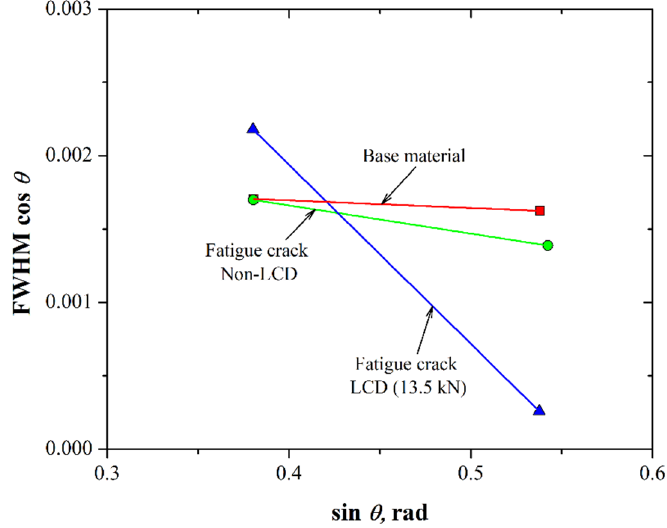
Figure 10. Residual strain approximation obtained from the fitting to the Williamson–Hall equation (Equation (3)) for the 7075-T651 aluminum alloy. (Equation (3)) for the 7075-T651 aluminum alloy.